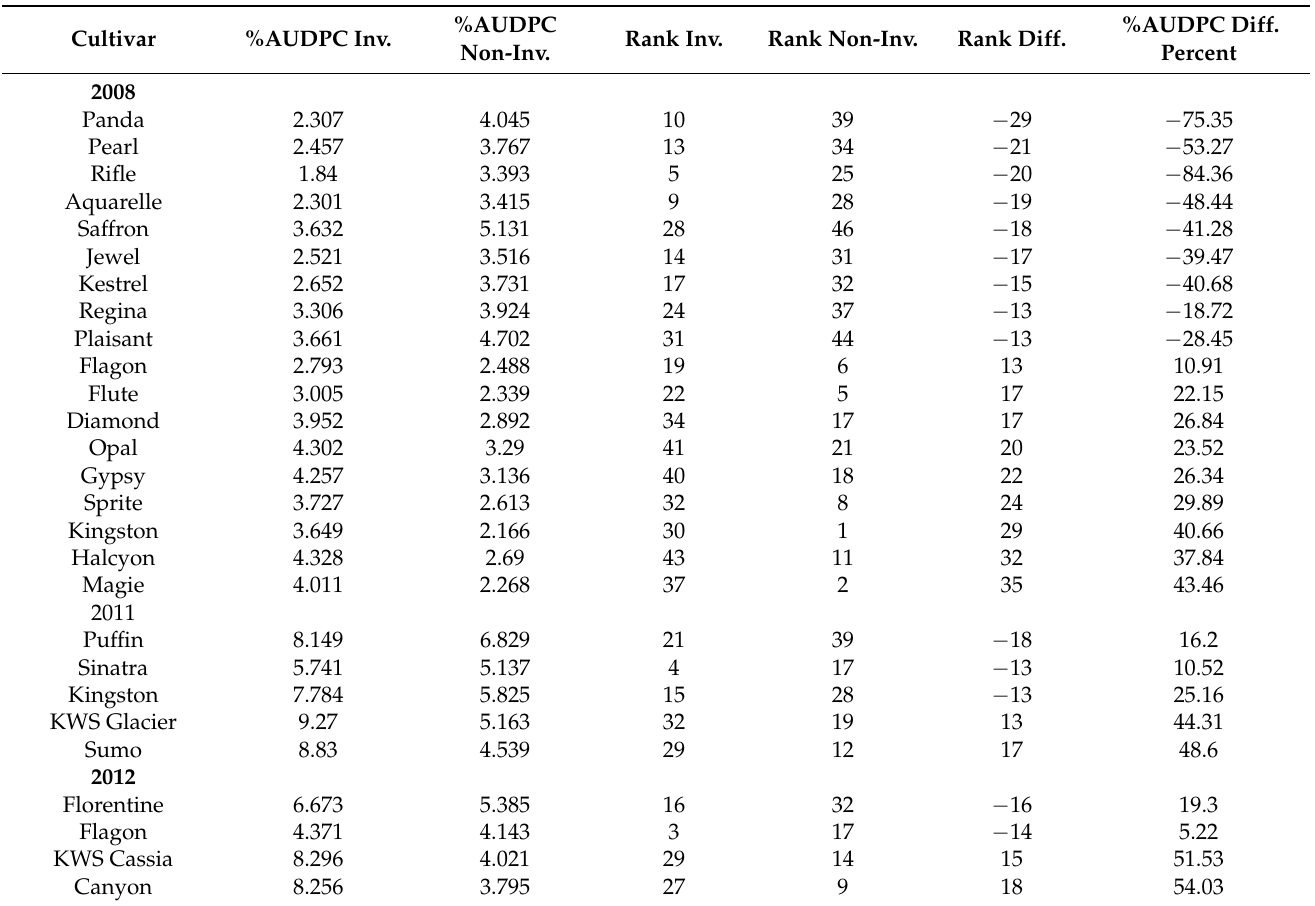
Table 16. Ranking of winter barley cultivars grown in the 2008, 2011 and 2012 trials by the difference between their inversion and non-inversion area under their rhynchosporium disease progress curve (%AUDPC)(sqrt) ranking that change rank by more than 13